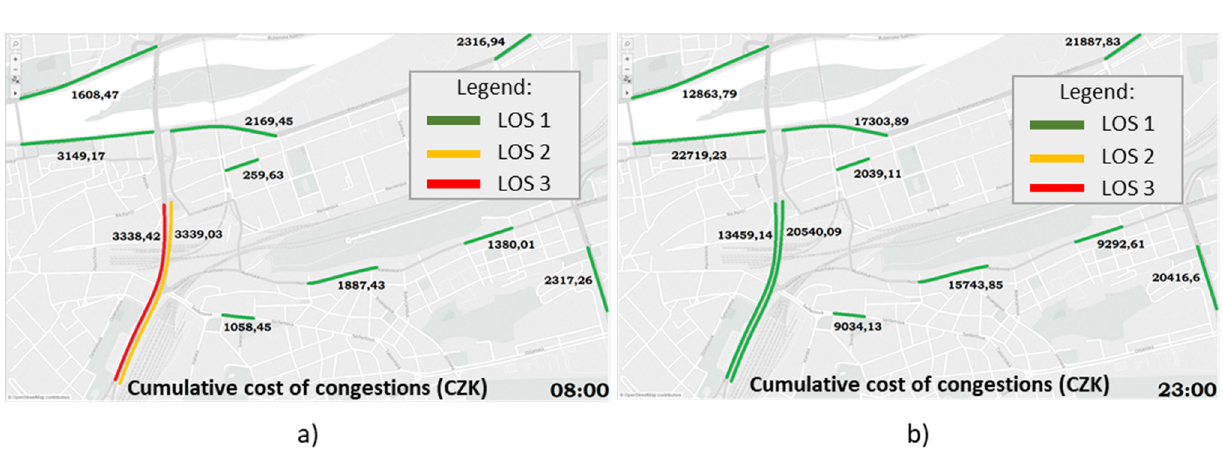
Figure 4. Comparison of fuel consumption (in liters per 100km) according to models HERA COPERT and TRANSYT.